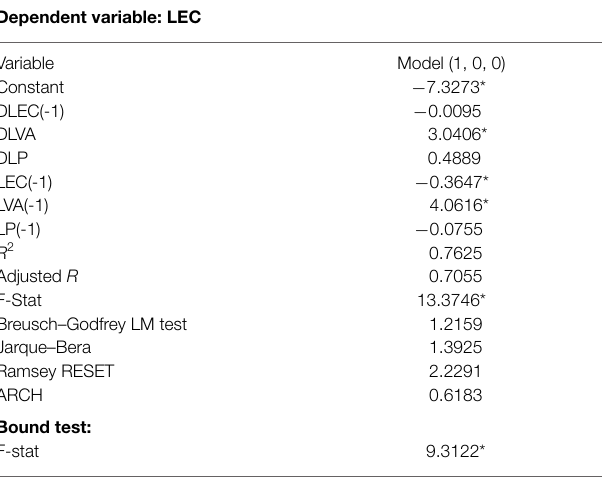
TABLE 3 | Estimation of unrestricted error correction model (UECM) .